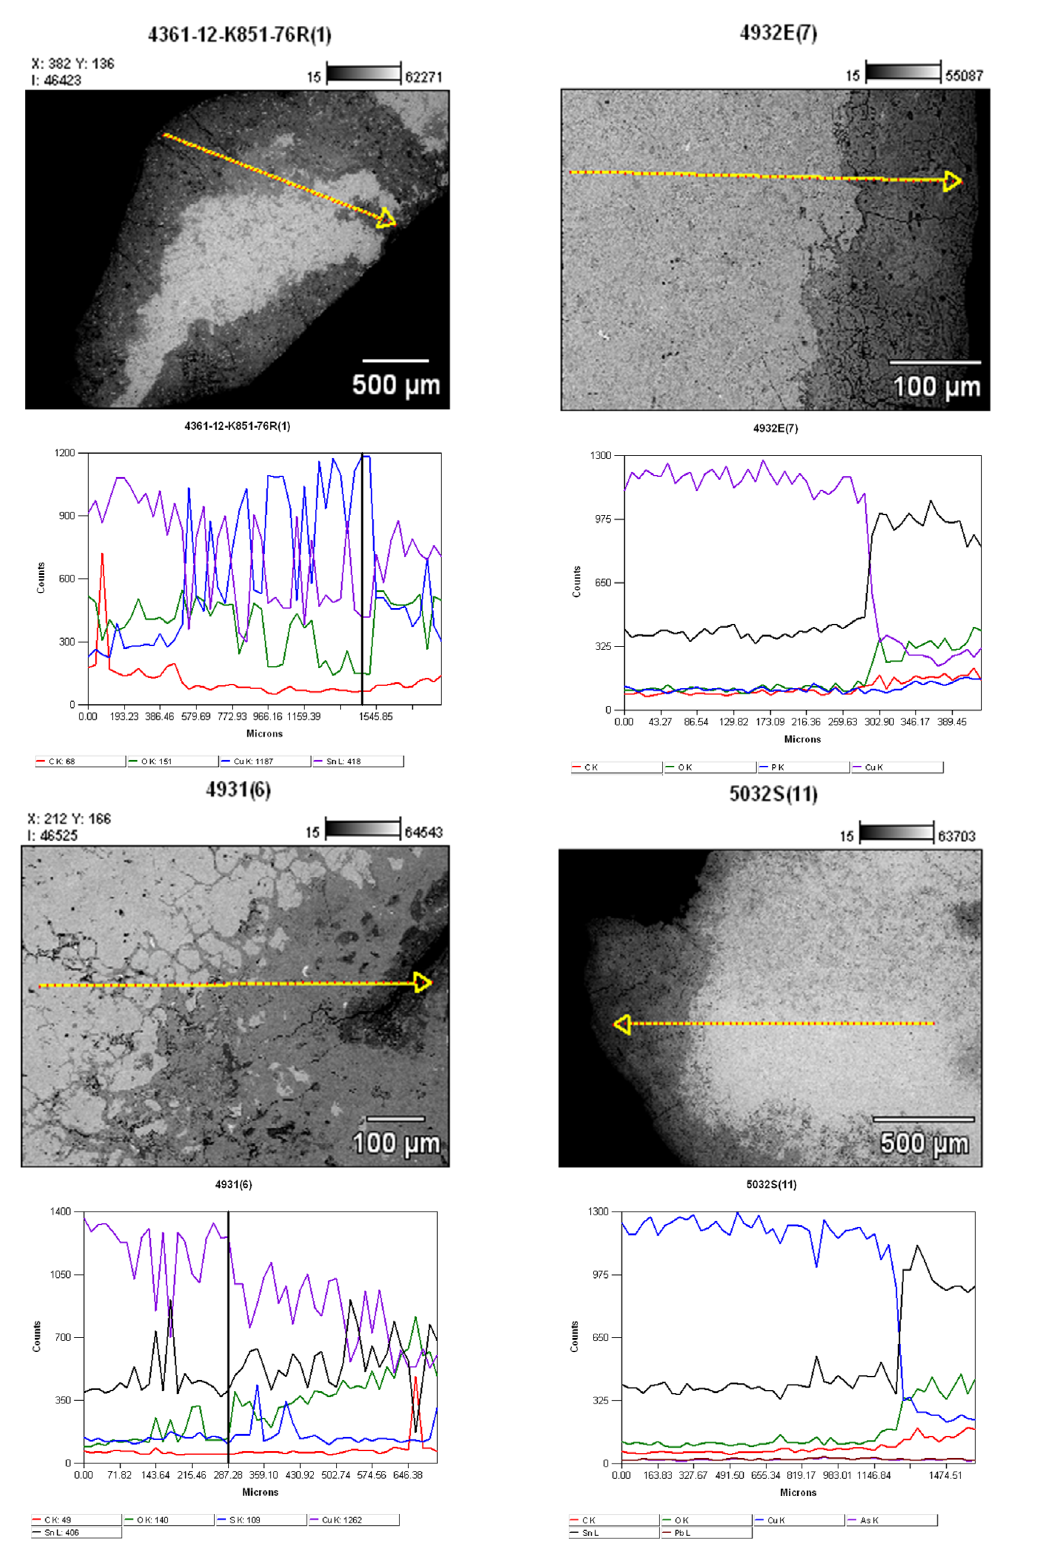
Figure 5. Elemental curve from several samples taken for metallographic analyses. Top left, Bleckmar, Celle, Lower Saxony (LMN K851:76); Top right, end part of the collar from Raven, Kr. Harburg, Lower Saxony (LMN 4932); Left, Rehlingen, Lüneburg, Lower Saxony (LMN 4931); Right, shaft of the pin (LMN 5032) from Rehlingen, Lüneburg, Lower Saxony (scan: Dirk Kirchner, German Mining Museum,